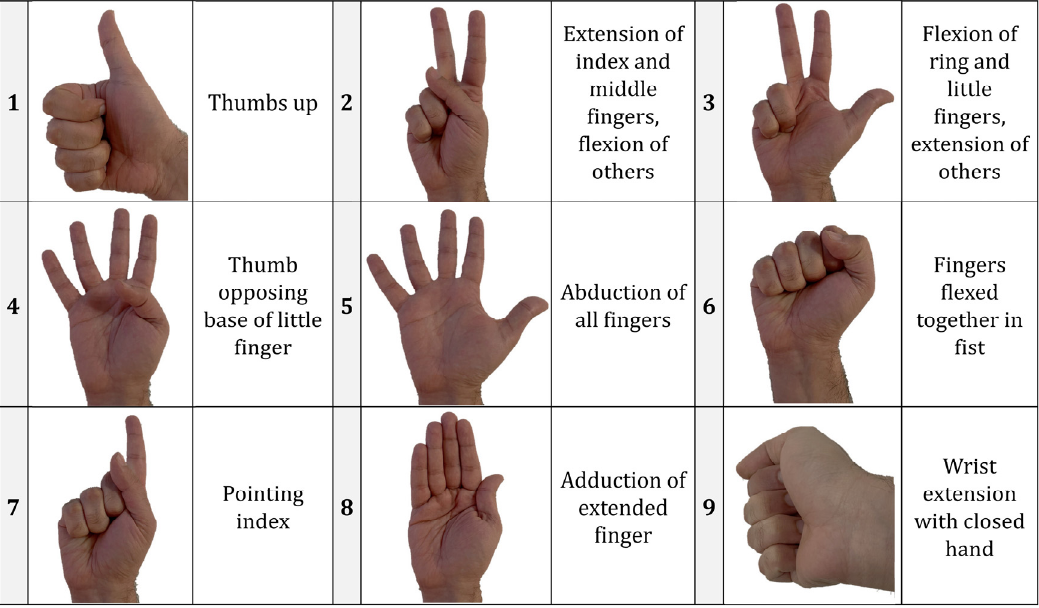
Figure 1. Gestures of interest used for the EMG classification based on the NinaPro dataset [25]. Table 1. Details of the transradial amputee subjects relevant to the research